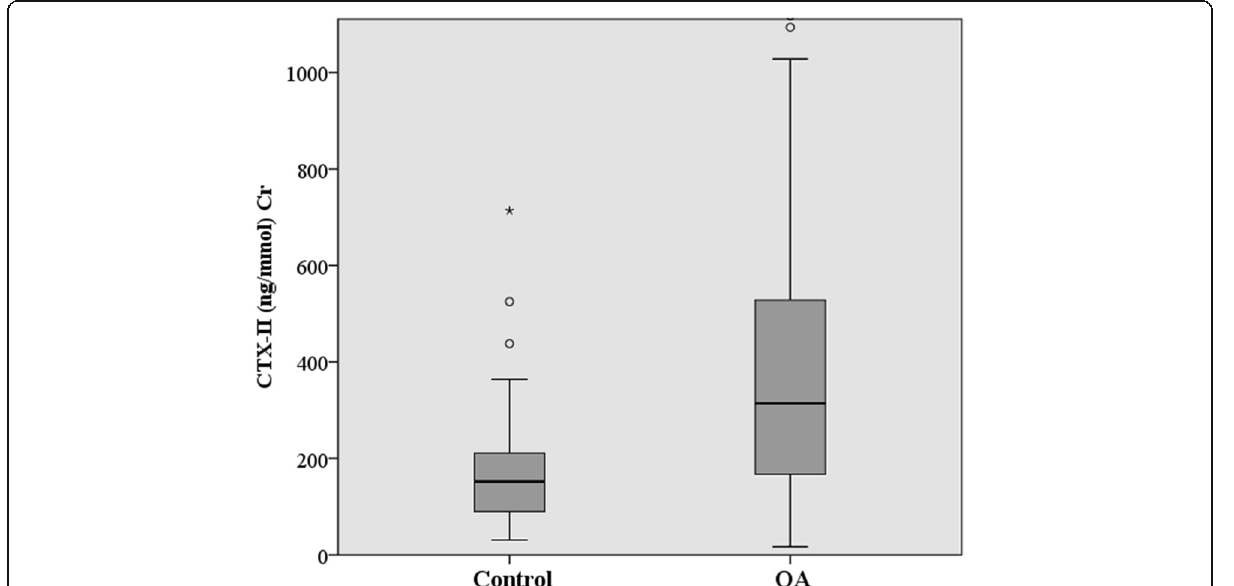
Fig. 1 Comparison of the levels of urinary CTX-II between knee OA patients and controls